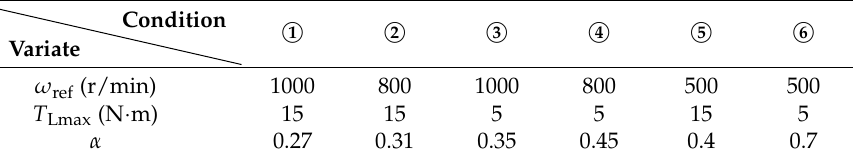
Table 2. Different operating conditions that correspond to Figure 8.